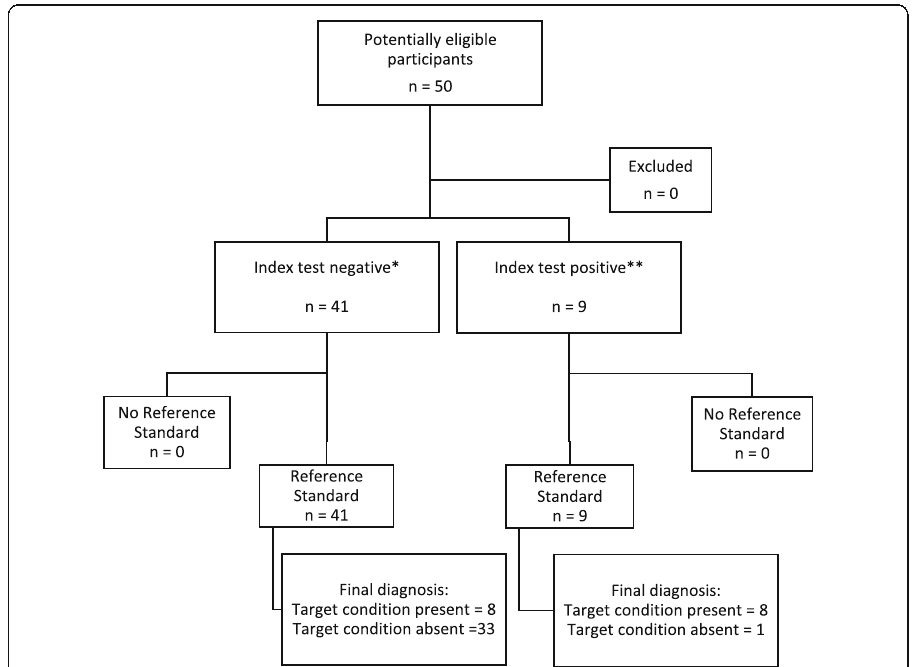
Fig. 1 Flow of participants through the study. *Defined as Δ ET-CO2<2 mmHg; **defined as Δ ET-CO2 ≥ 2